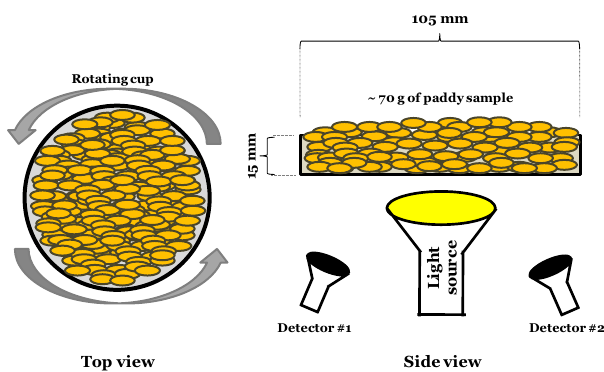
Fig. 1. Schematic diagram of re°ectance NIRS measurement displaying in top view and side